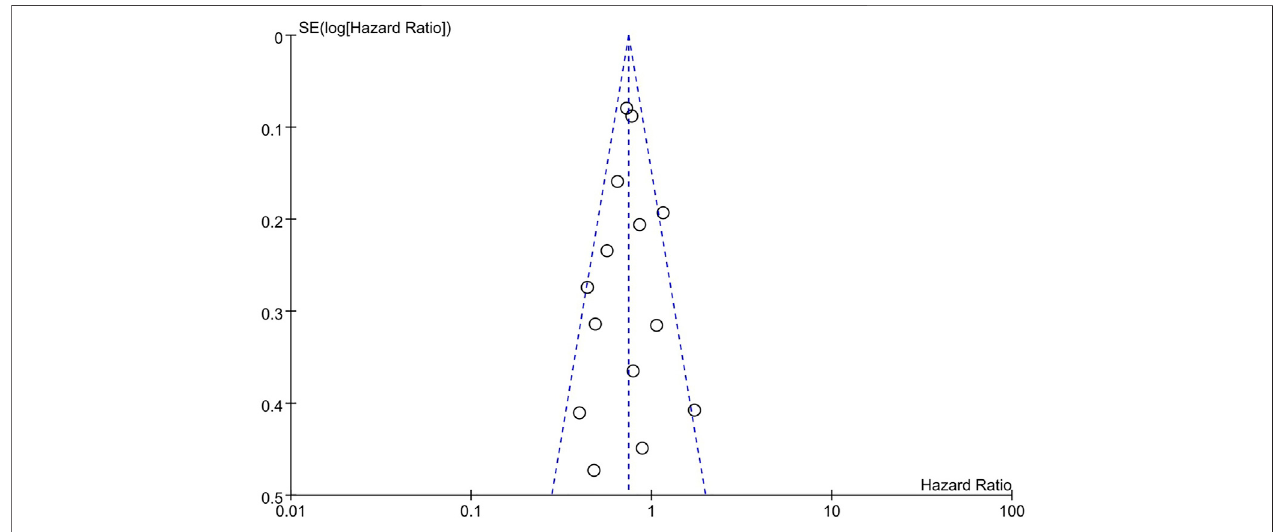
FIGURE 4 | Publication bias assessment of primary